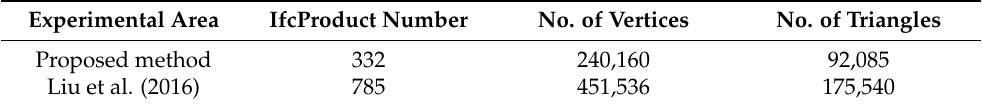
Table 6. Statistical information for all building entities when the outdoors is visible. Experimental Area IfcProduct Number No. of Vertices Experimental Area IfcProduct Number No. of Vertices